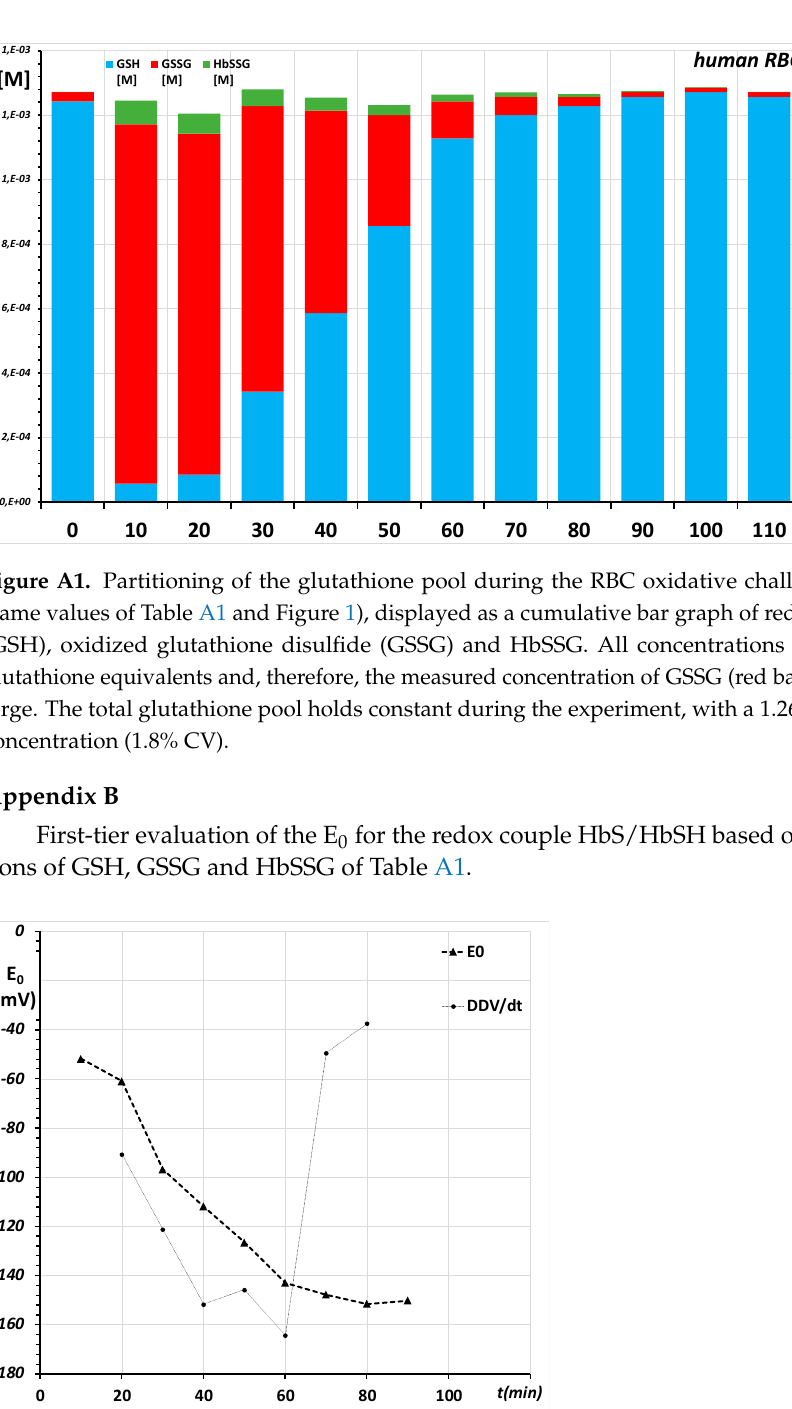
Figure A3. Least-squares residuals plot of calculated and measured concentrations of HbSSG, cal- culated by changing the value of E 0 between − 130 and − 115 mV in 1-mV steps.